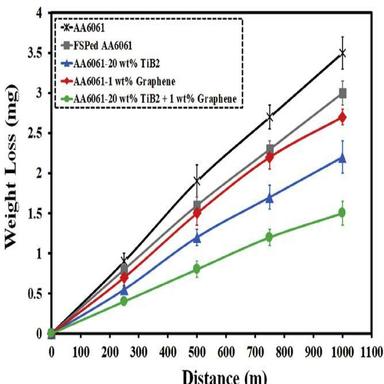
Variations of weight loss versus sliding distance for optimum compositions of processed single and hybrid nanocomposites.